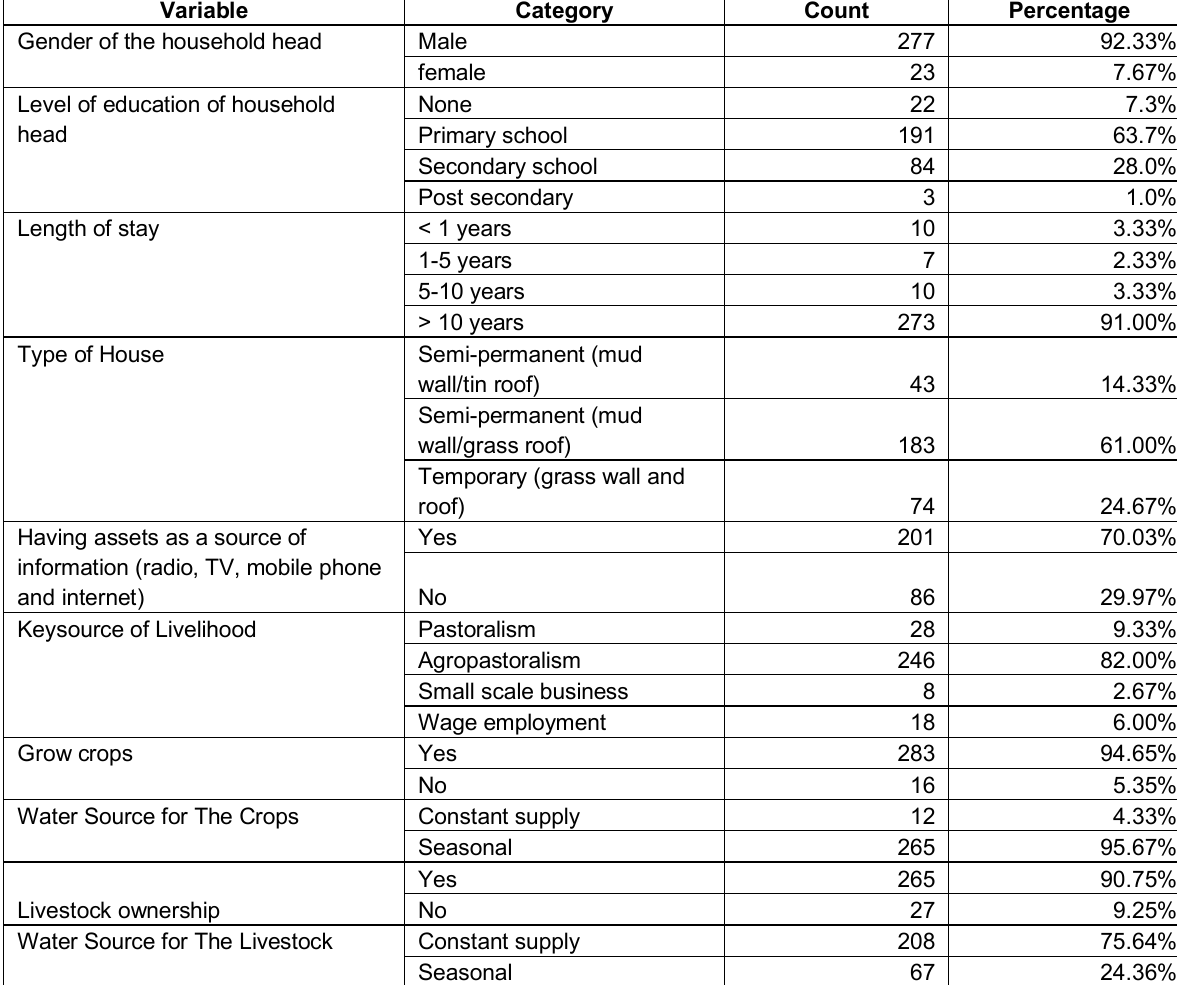
Table 1: Descriptive statistics of the households